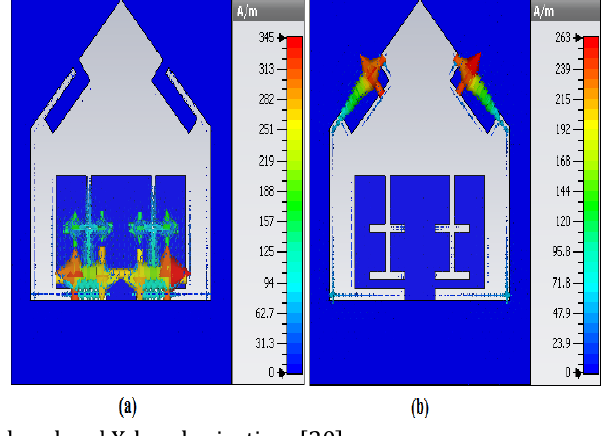
Figure 11: The Current distributions (a) 5.5 GHz, (b) 8 GHz.